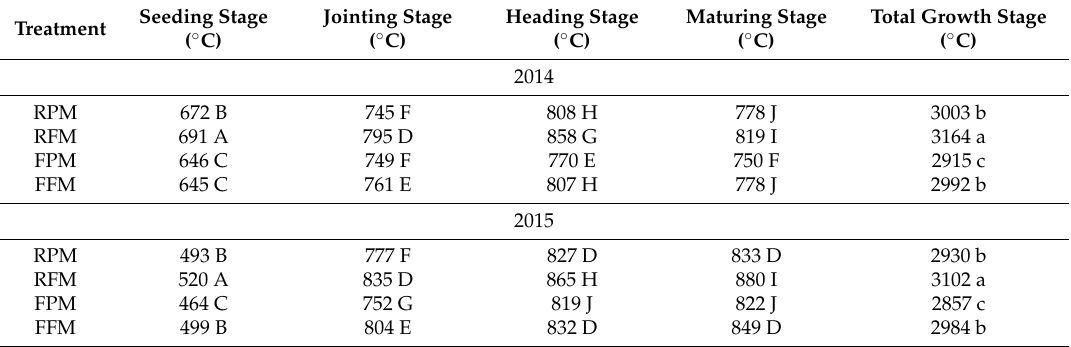
Table 3. Accumulated soil temperature under different treatments during the growth period in 2014 and